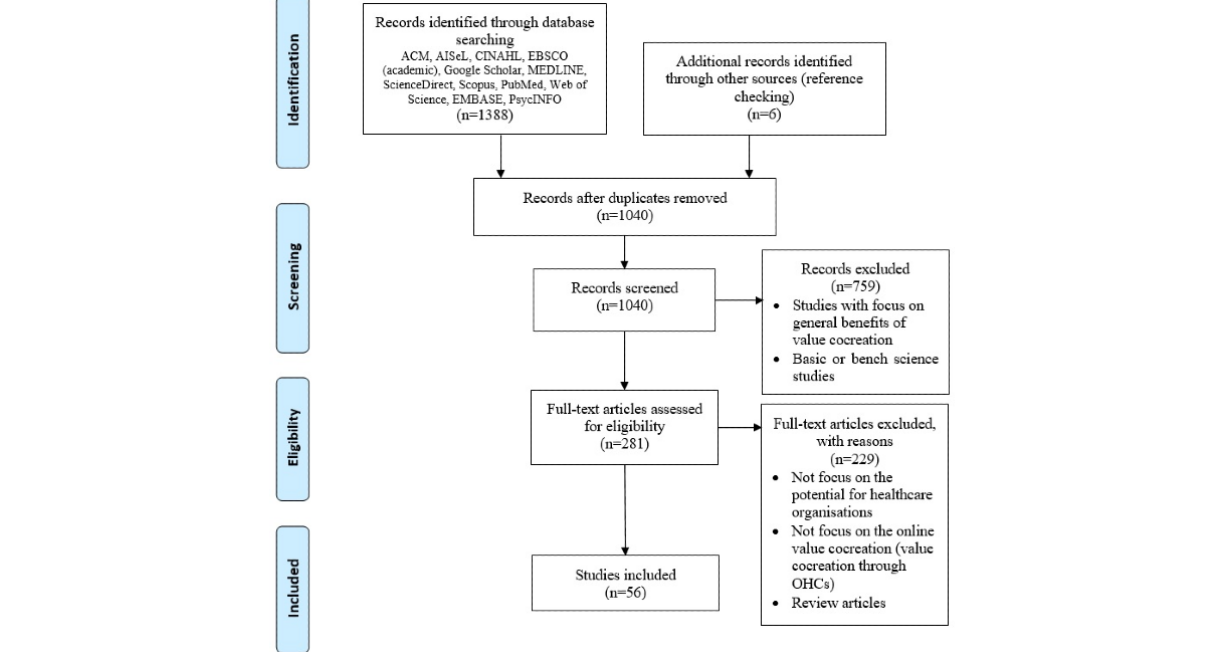
Figure 1. Flow diagram of the literature search. ACM: Association for Computing Machinery; AISeL: Accelerated Information Sharing for Law Enforcement; CINAHL: Cumulative Index of Nursing and Allied Health Literature; EBSCO: Elton B Stephens Co; MEDLINE: Medical Literature Analysis and Retrieval System Online; OHC: online health